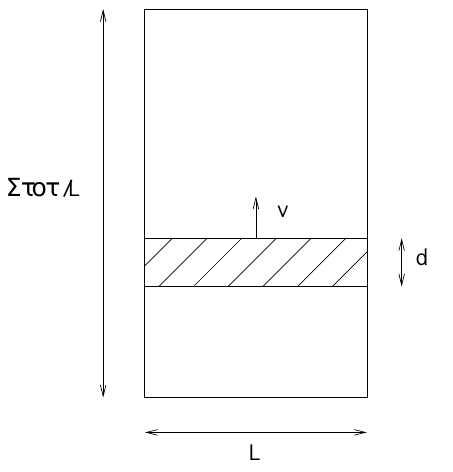
Fig. 1. Schematic view of the propagation of an idealized fire. The rectangular front of width L and depth d propagates at speed v ...